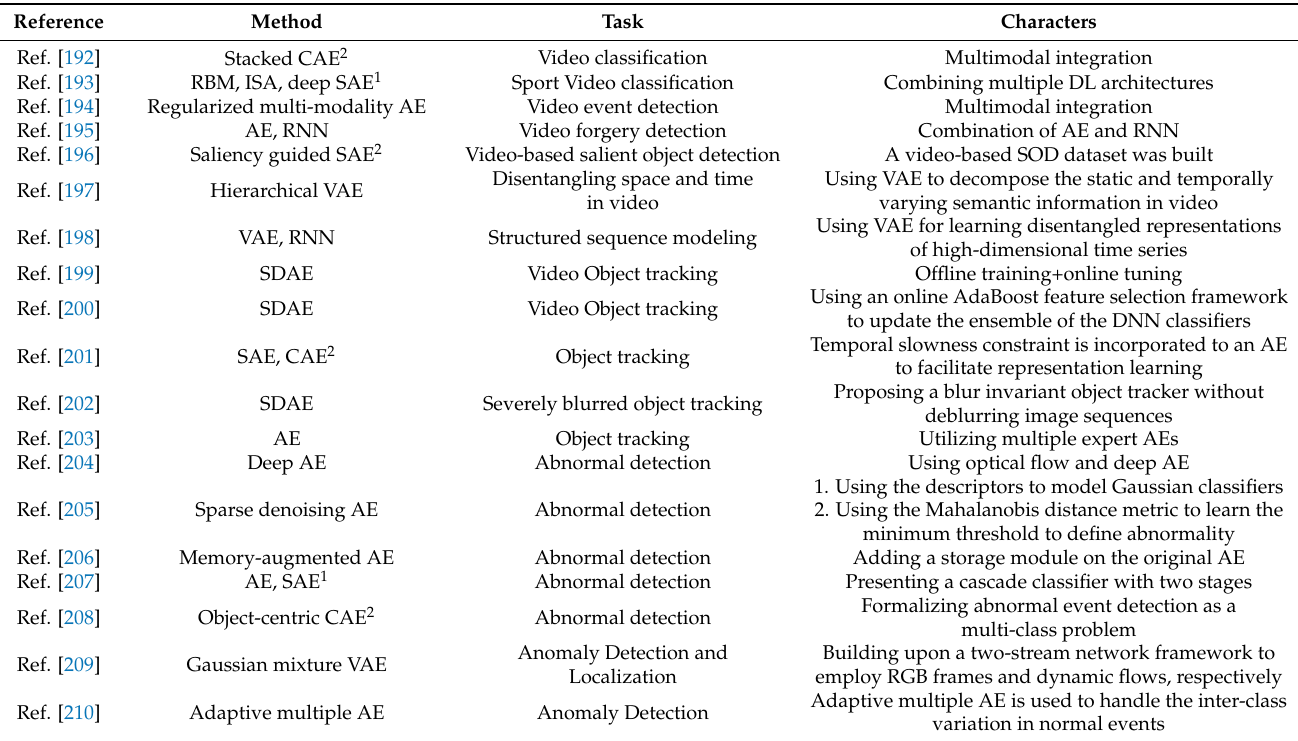
Table 2. Various AE models used in video